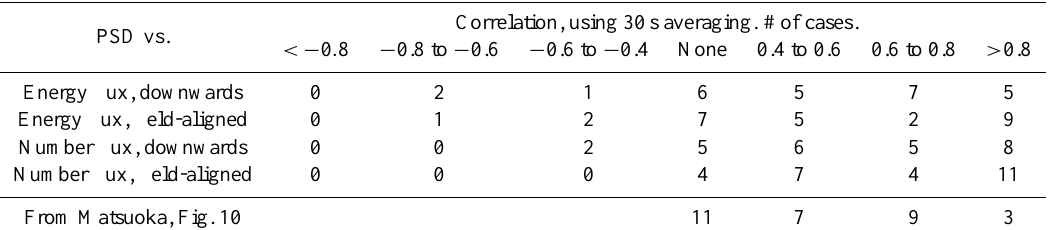
Table 1. Each row shows a summary of the correlation coefficients of the Power Spectral Density (PSD) of the electric field fluctuations around 1Hz versus one type of ion flux, with each column containing the number of cases with a correlation within the interval shown in the column header. 30s averages of the wave power and flux levels were used for the calculations. The total number of cases is 26. “field-aligned” flux is the sum of the absolute values of upward and downward flux. A summary of the correlation results of Matsuoka et al. (1993) have been included for comparison.